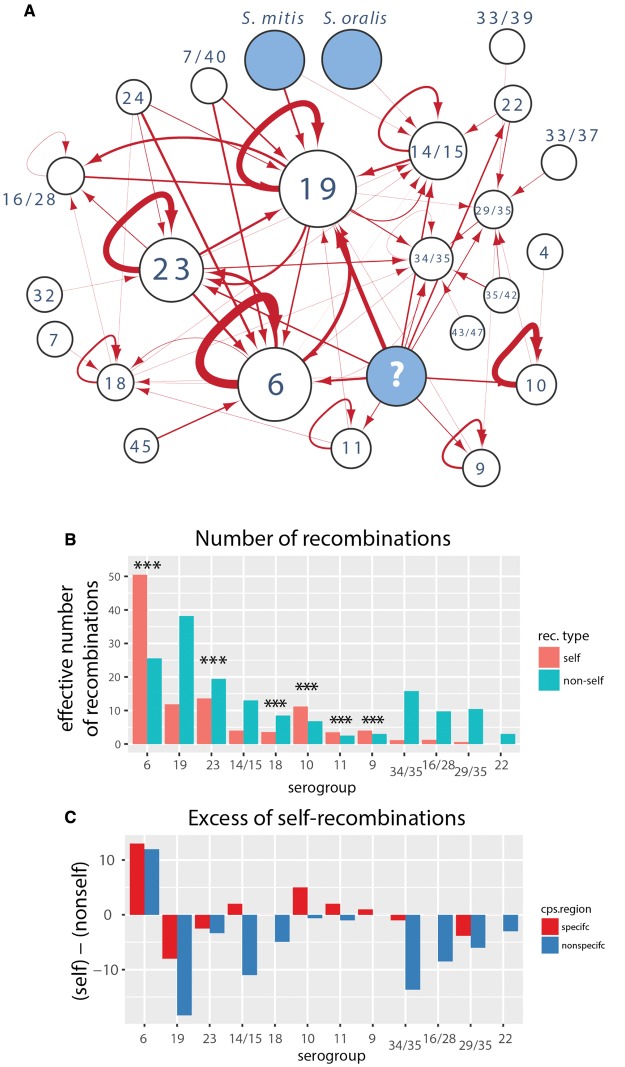
Origin of cps recombinations. (A) The network shows the recombination flow among the serogroups defined in figure 1A: nodes correspond to serogroups and arrows correspond to the direction of cps recombination flow based on the most likely origin of the putative recombination events. The width of arrows reflects the number of recombination events (between 0 and 51) and the size of the nodes reflects the number of isolates within the serogroup (except for “unknown” and other streptococci). (B) Proportion of cps recombinations originating in the same serogroup (self) versus another serogroup (nonself) for each serogroup. Stars show significance of the departure from random distribution of recombination exchanges. The significance was calculated assuming a binomial distribution of self-/nonself-recombination with the probability corresponding to the frequency of self-/nonself-serogroups. (C) Excess of self- over nonself-recombinations in the cps-specific and cps-nonspecific region, as defined in the main text.